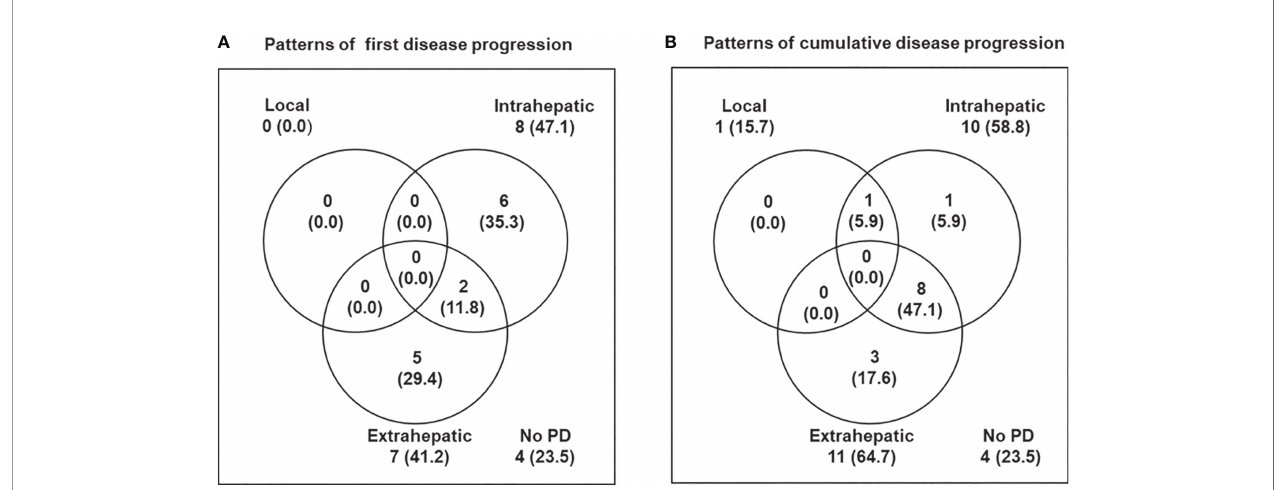
FIGURE 2 | Patterns of disease progression. (A) First and (B) cumulative disease progression at the time of